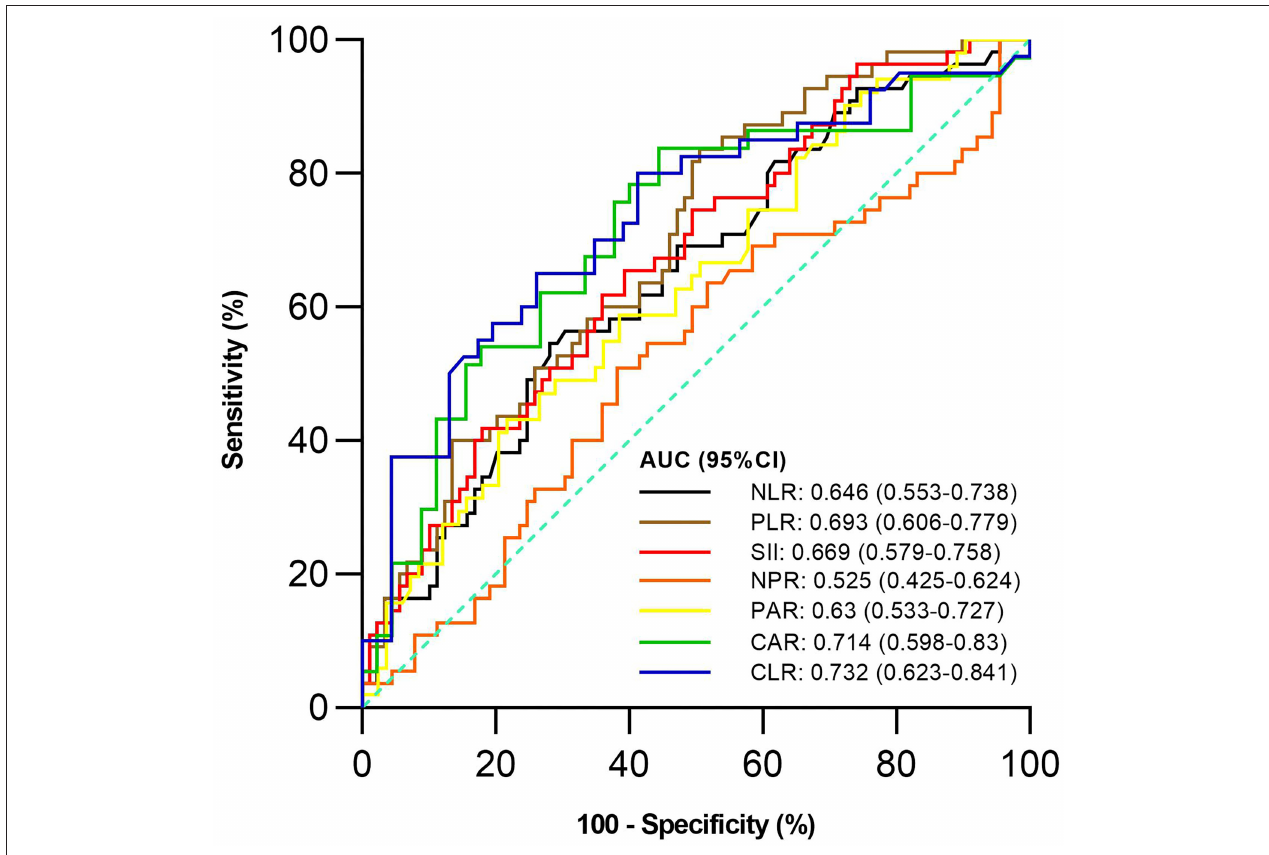
FIGURE 3 | Comparison of the predictive performance of inflammatory indexes for severe UC. UC, Ulcerative colitis; AUC, Area under the curve; CI, Confidence interval; NLR, Neutrophil-to-lymphocyte ratio; PLR, Platelet-to-lymphocyte ratio; SII, Systemic immune-inflammation index; NPR, Neutrophil-to-platelet ratio; PAR, Platelet-to-albumin ratio; CAR, C-reactive protein-to-albumin ratio; CLR, C-reactive protein-to-lymphocyte ratio. was 2.41mg/g with a sensitivity and specificity of 58.33% and 95.38%, respectively ( Supplementary Table 3 ). The AUC of CAR was significantly different from that of PLR ( P = 0.0014), but not NLR, SII, NPR, PAR, or CLR ( P = 0.055, 0.0673, 0.1451, 0.1529, or